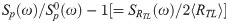
Spectral analysis of protein number fluctuation.(A) Reaction network model of luciferase expression controlled by the Bmal 1a promoter in mouse fibroblast cells [56]. ψon(t) and ψoff(t) represent the lifetime distribution of the active and inactive gene states, respectively. (B) Model of the gene deactivation and activation cycle of the Bmal 1a promoter. Gene deactivation is a simple Poisson process, but gene activation is a non-Poisson process composed of N consecutive Poisson processes. (C) Frequency spectrum of protein number at three different ratios of the mRNA lifetime to the protein lifetime. (circle) simulation results; (lines) theoretical results. (D) Modified frequency spectrum of protein number or mean-scaled frequency spectrum of translation rate, Sp(ω)/Sp0(ω)−1[=SRTL(ω)/2〈RTL〉]. Sp0(ω) is defined as Sp0(ω)=2〈R〉/(ω2+γp2). In the high frequency regime, the asymptotic behavior of the modified frequency spectrum is given by kTLγmω−2, i.e., limω→∞ω2[Sp(ω)/Sp0(ω)−1]=kTLγm. (E) Frequency spectrum of the mRNA number. (triangles) data extracted from the frequency spectrum data, Sp(ω), of the protein number with use of Eq 8. (circles) simulation results, (lines) the theoretical results of Eqs 3 and 10. (F) Modified mRNA number frequency spectrum or mean-scaled frequency spectrum of transcription rate. (triangles) data extracted from Sp(ω) with use of Eqs 8 and 9. (line) the theoretical result of Eq 10.